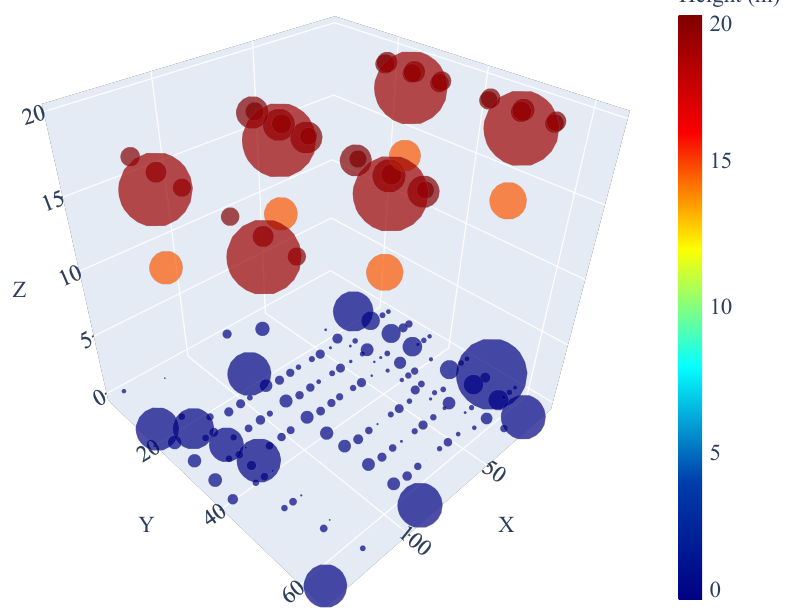
Figure 24. Spatial graph showing the height of the equipment and the positioning errors of the manual design